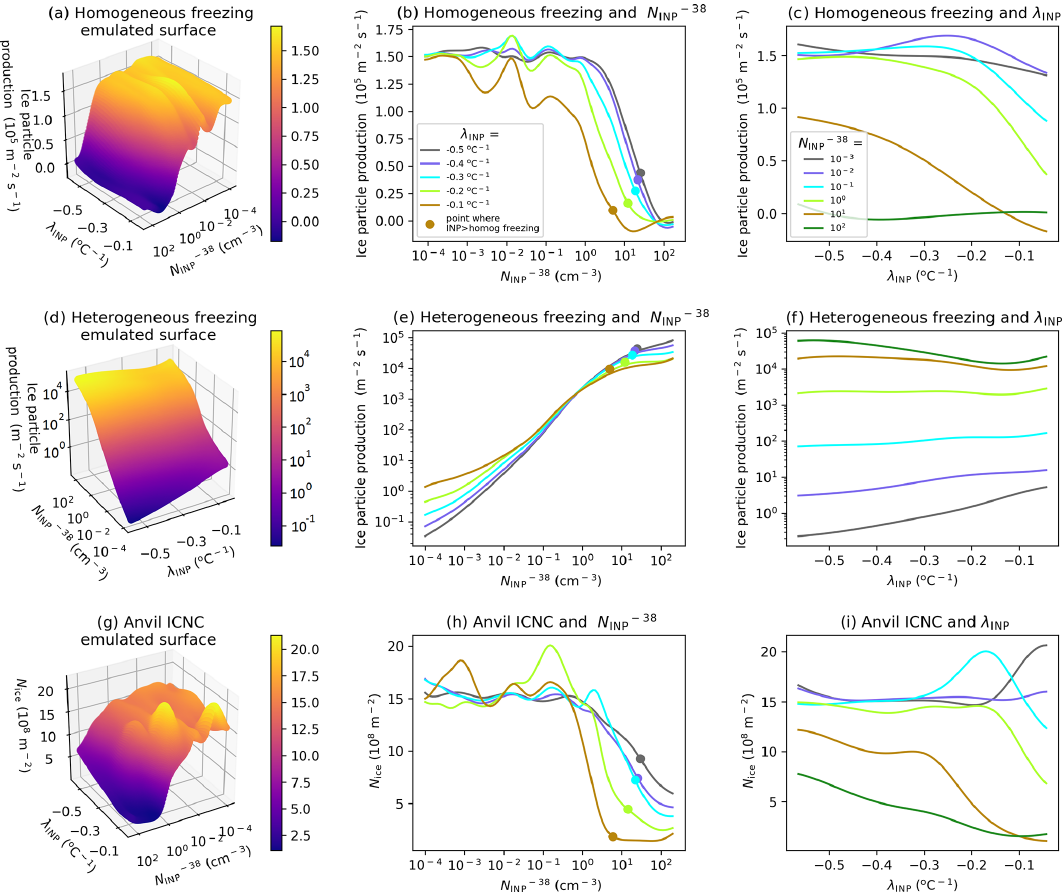
Figure 8. Emulator response surfaces. Prediction of ice particle production by homogeneous freezing (a–c) , heterogeneous freezing (d–f) , and anvil ICNC (g–i) by the emulator. Shown in panels (a) , (d) , and (g) are emulated response surfaces at a fixed HM-eff of 350 splinters produced per milligram of rimed liquid. The colours indicate output values and are the same range and units as the z axis. The line plots show the variation in predicted output value ( y axis) from these response surfaces for fixed λ INP (b, e, h) and fixed N INP − 38 (c, f, i) . Panels (a) – (f) are the average of the cloud property between 60 and 180min (convective stage) of the simulation, while panels (g) – (i) are the average of the relevant cloud property between 150 and 240min (anvil stage) of the